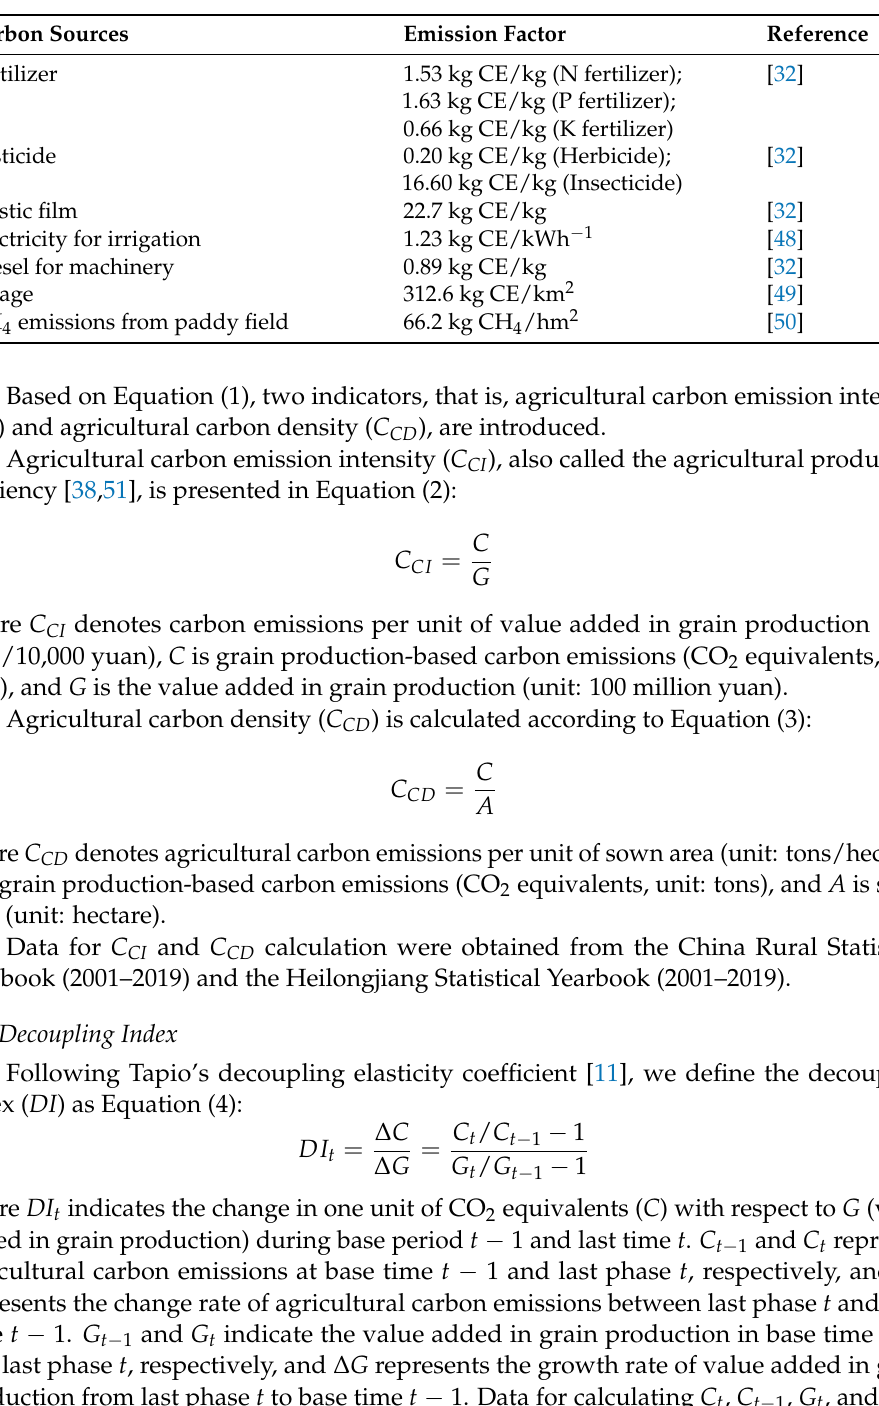
Table 1. Carbon emission